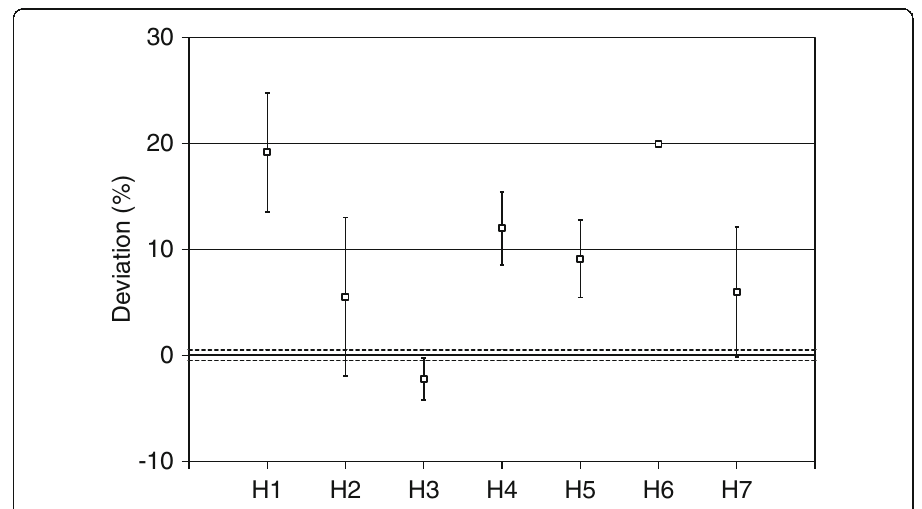
Fig. 6 Participants reported activities for the inner sphere of the comparison